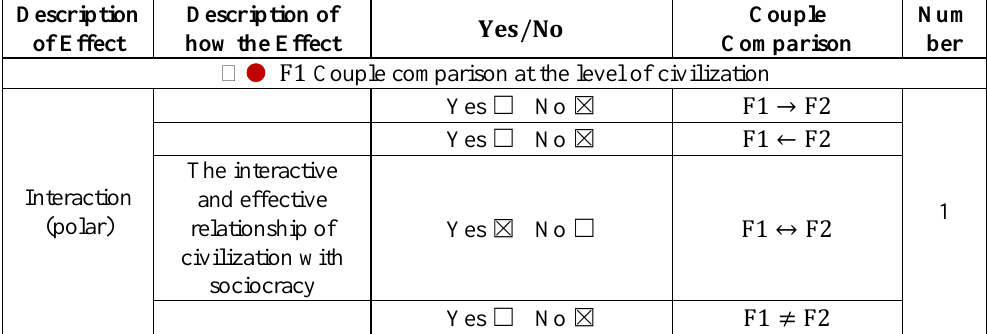
Table 10. Couple comparison of Corporate Governance Civilization